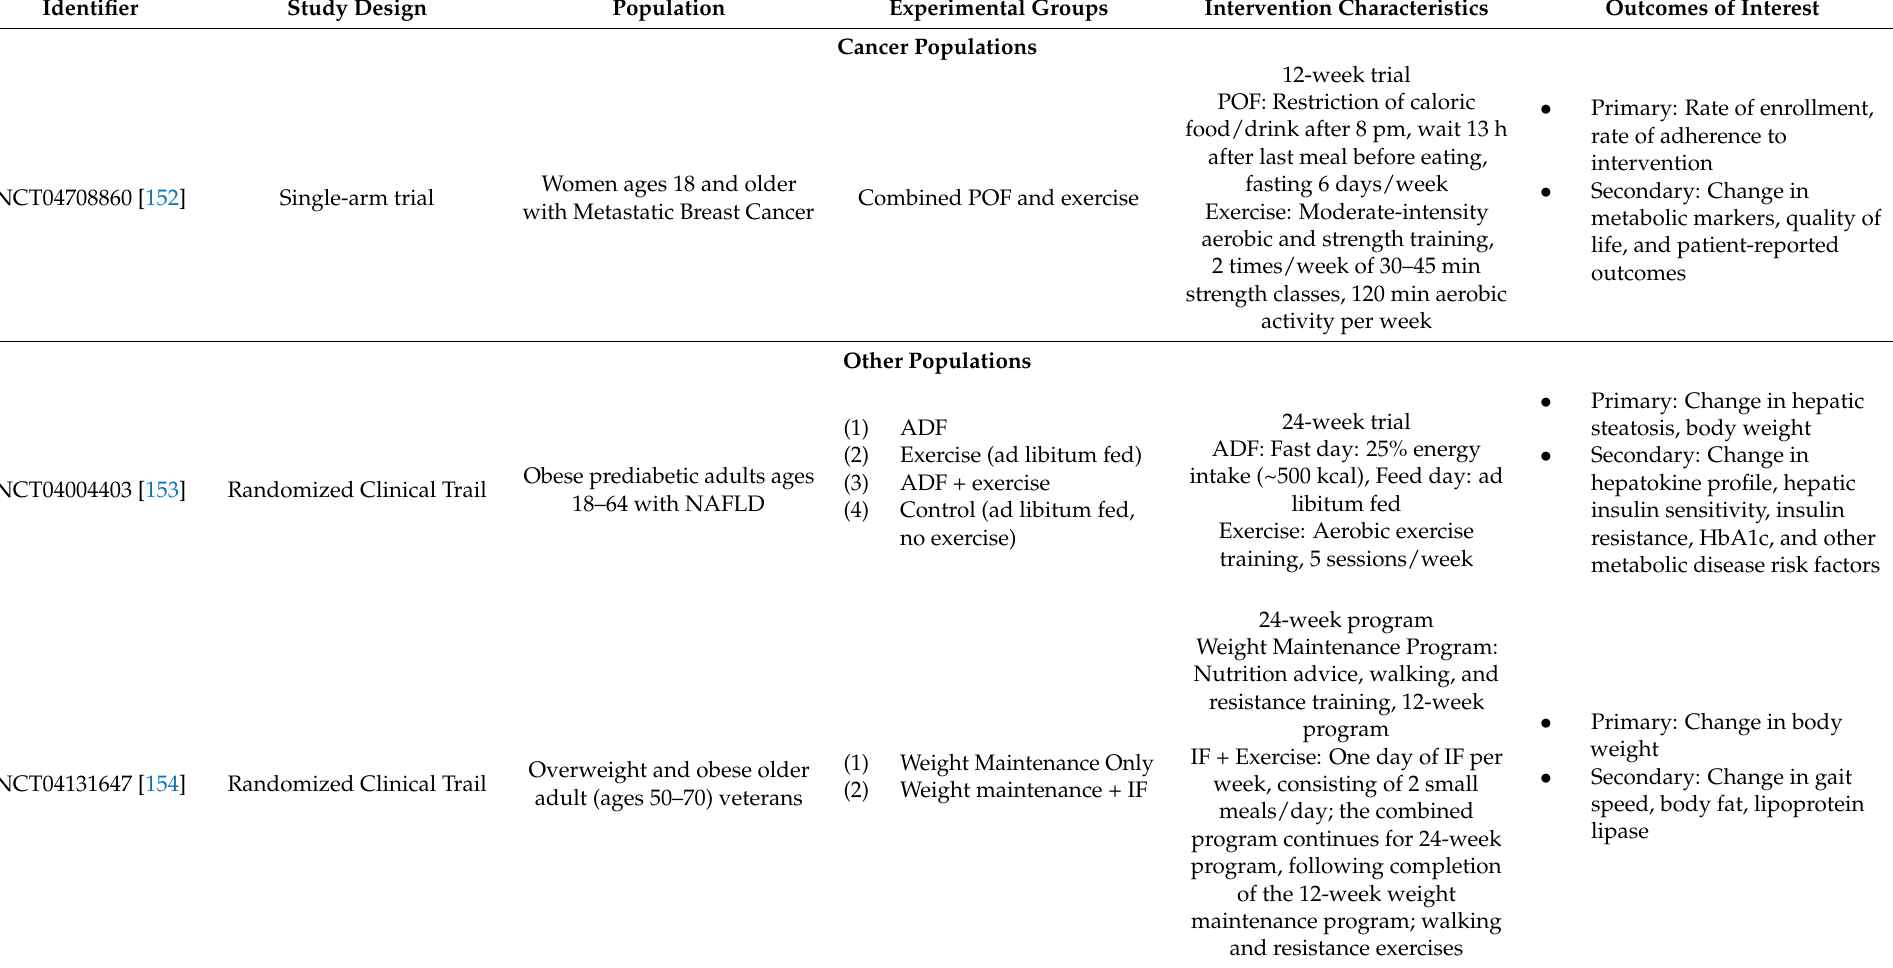
Table 2. Ongoing clinical trials with combined fasting and exercise interventions (http://ClinicalTrials.gov, accessed on 1 September